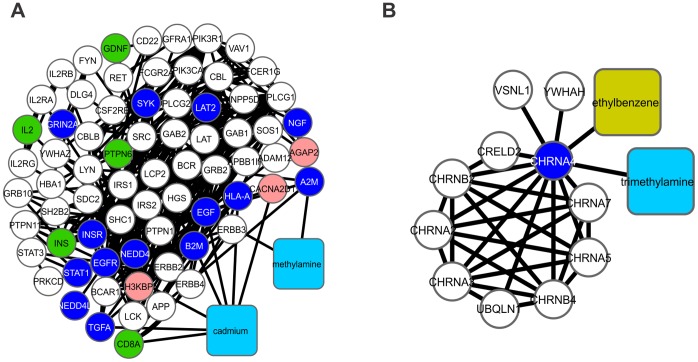
Cluster analysis of the major CPI-PPI network and the modules related to cell-cell signaling.Cluster 2 (A) is composed of 73 nodes and 354 edges, with Ci = 4,849. Cluster 2 contains the two hydrophilic substances cadmium and methylamine. Related GO term: regulation of cell communication. Cluster 18 (B) is composed of 13 nodes and 30 edges, with Ci = 2, 304. Cluster 18 contains one hydrophilic compound, trimethylamine, and one lipophilic compound, ethylbenzene. Related GO term: cell-cell signaling.